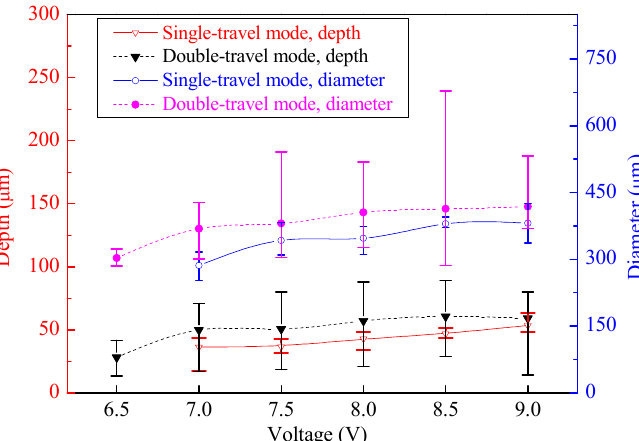
Figure 9. Morphologies of the arrayed micro ‐ dimples machined in the double ‐ travel mode and with the magnetic field (double ‐ travel time of 0.3 (cid:3400) 2 s, 8.5 V).